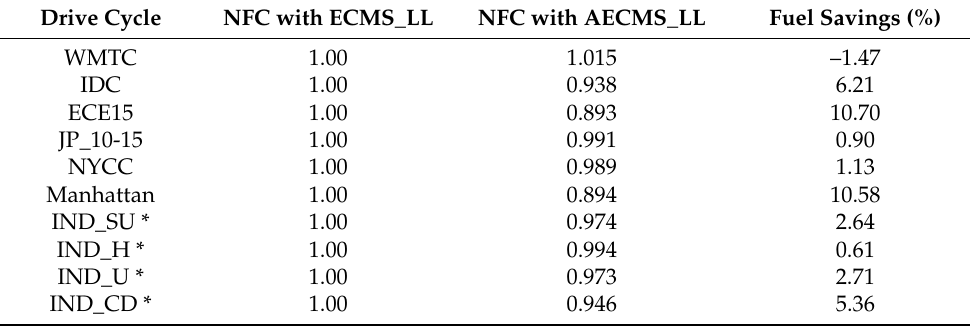
Table 5. Comparative study of fuel-saving for different drive cycles considered. Drive Cycle